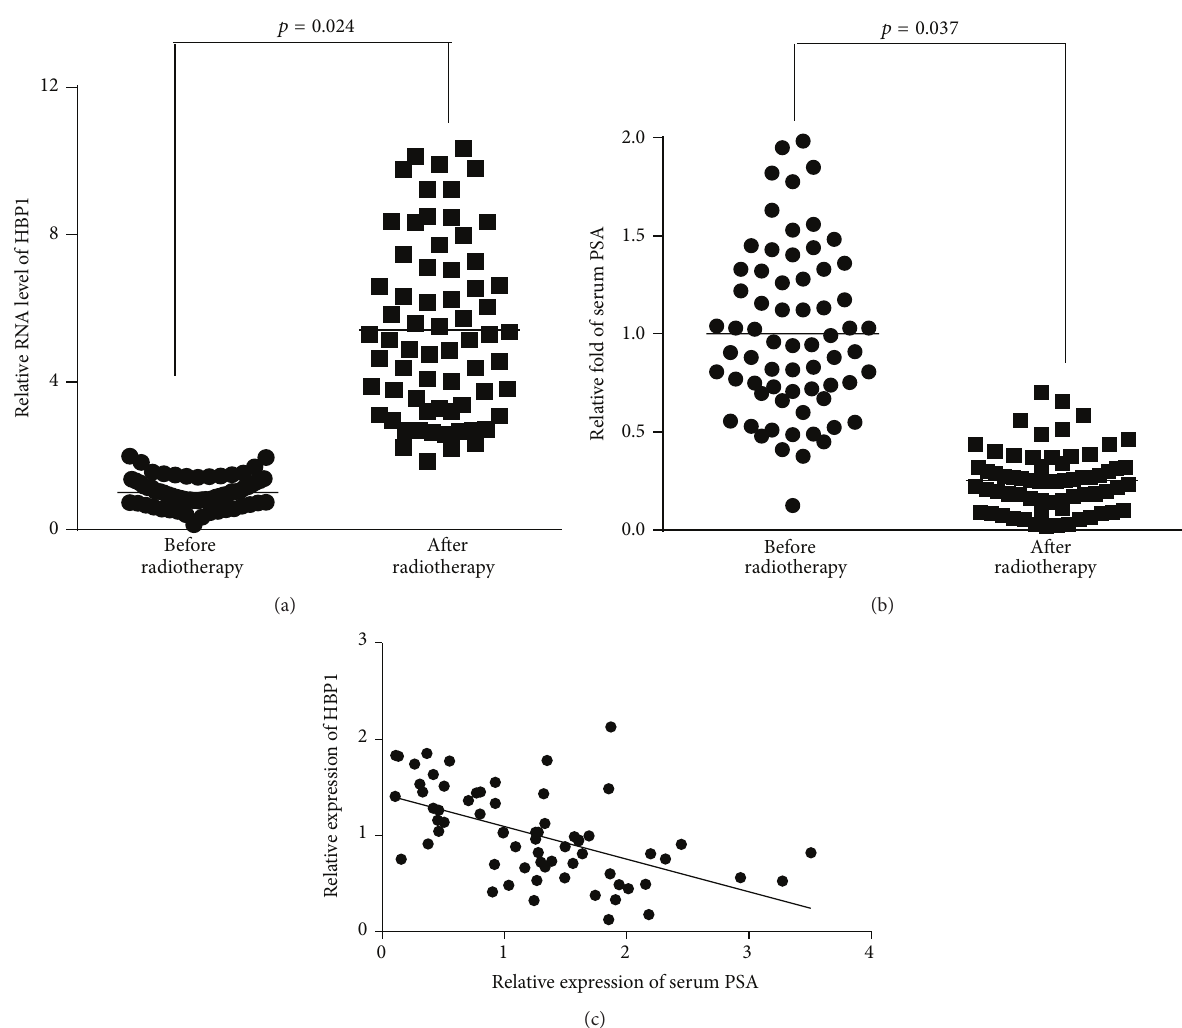
Figure 1: The relationship between prostate cancer brachytherapy efficacy and the expression level of HBP1 gene. (a) RT-PCR assay was used to detect the expression level of HBP1 gene in 66 pairs of blood samples of prostate cancer patients before or after brachytherapy. (b) The serum PSA level from patients was detected in 66 pairs of blood samples of prostate cancer patients before or after brachytherapy. (c) The relationship between the expression level of HBP1 and PSA was analyzed in 66 prostate patients who received brachytherapy.